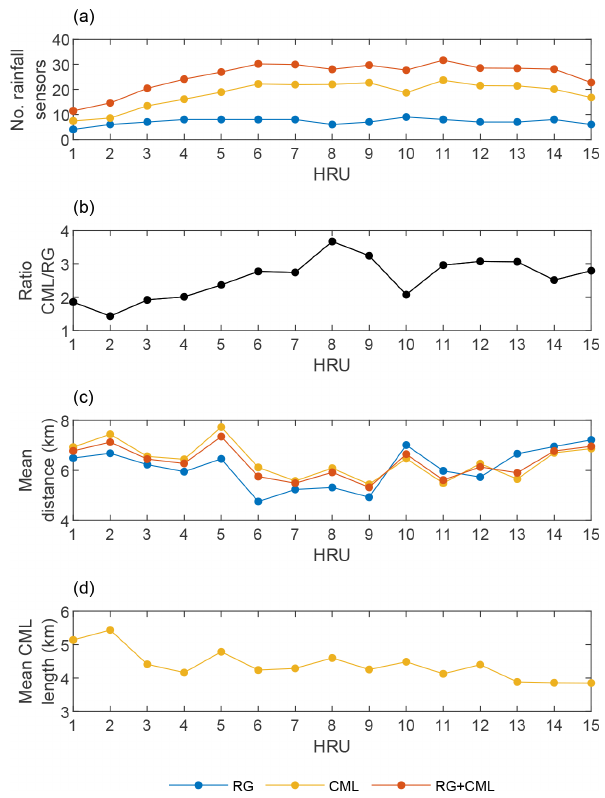
Figure 2. Panels (a) to (d) show the number of rainfall sensors used for spatial interpolation in each HRU centroid, the ratio between the number of RGs and CMLs, the mean distance between rainfall sen- sors and HRU centroids, and the CML mean lengths